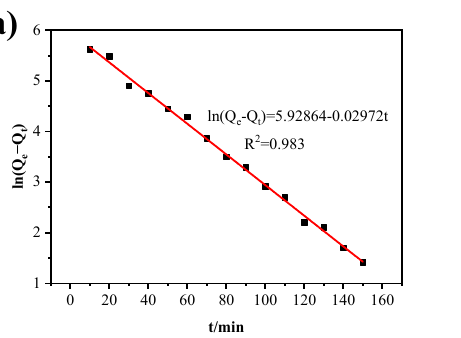
Figure 13. Pseudo-first-order ( a ), and pseudo-second-order ( b ), linear fitting of dynamics.